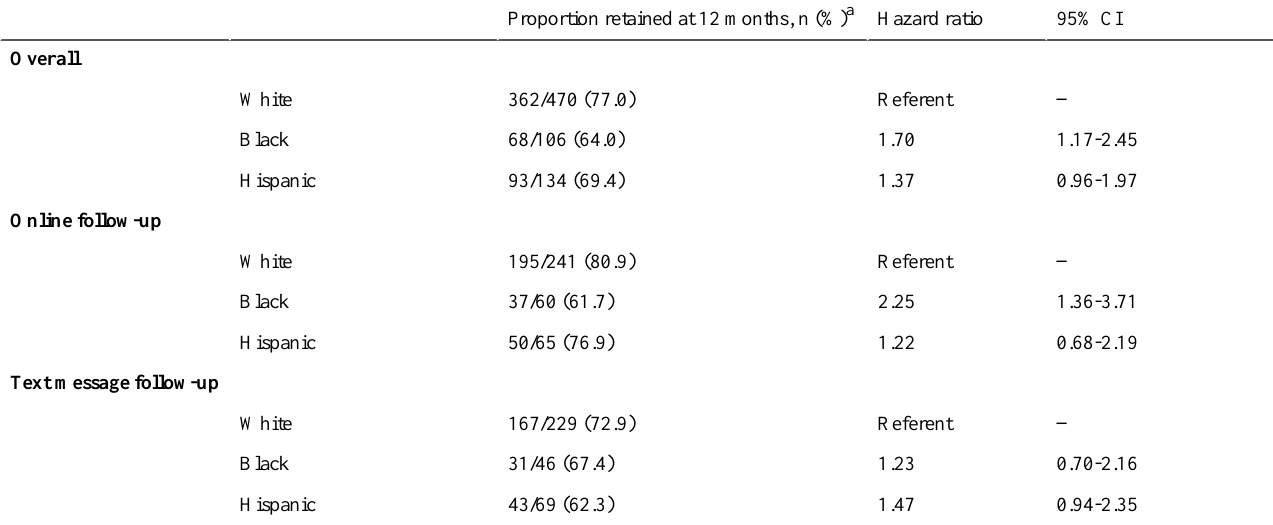
Table 3. Rate of loss-to-follow-up among men participating in a 12-month online study randomized to text message versus online follow-up, by race/ethnicity and stratified by randomization arm